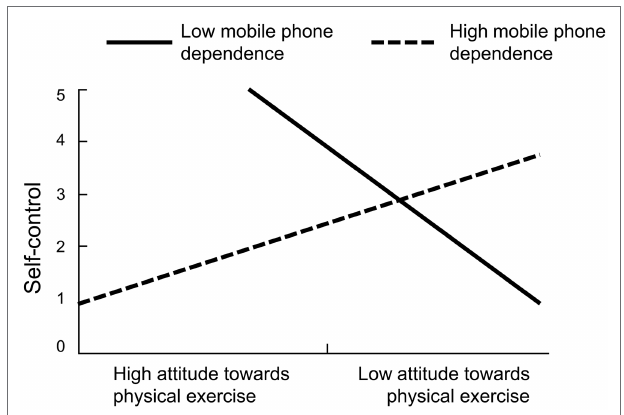
FIGURE 2 | The moderating effect of mobile phone dependence on self-